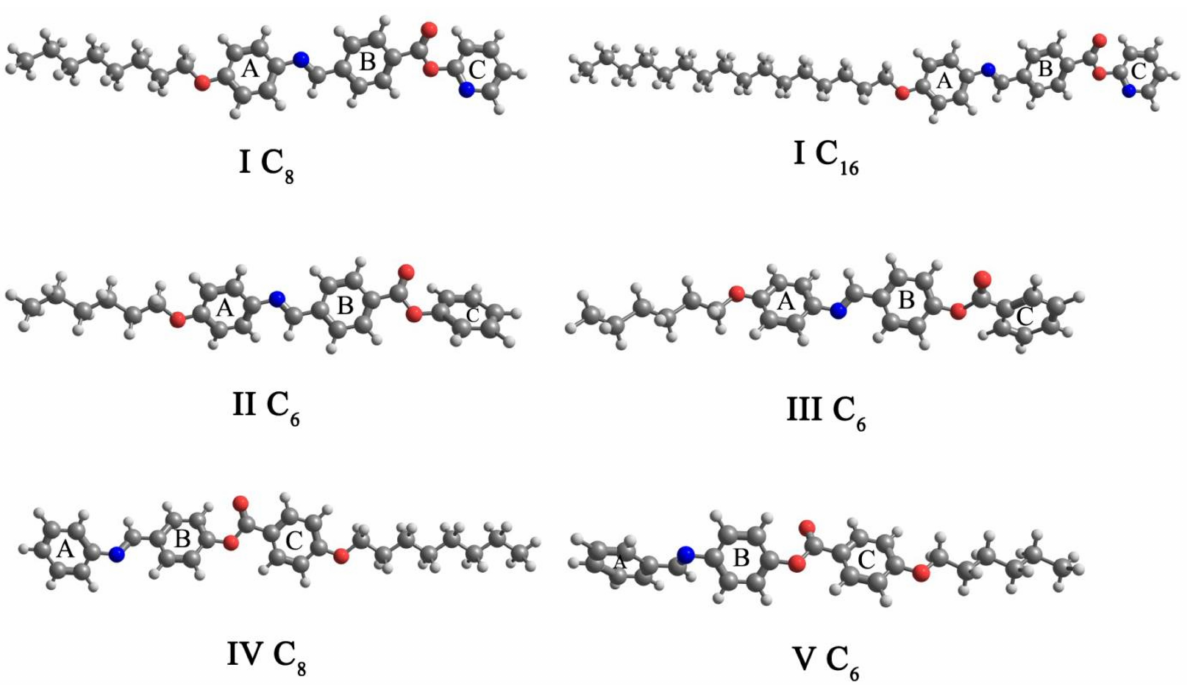
Figure 5. Calculated molecular geometrical structures of compounds I C 8 , I C 16 , II C 6 , III C 6 , IV C 8 , and V C 6 (blue—N, red—O, white—H, grey—C).